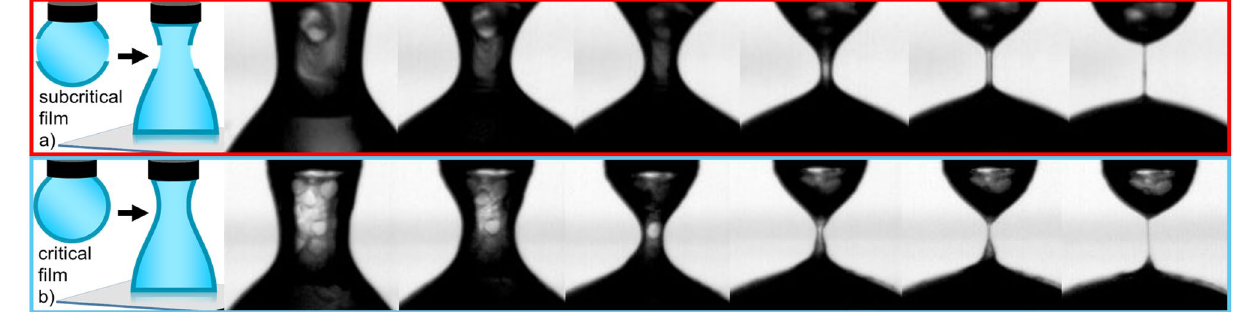
Figure 4. DoS images and schematic of proposed film formation for 3 mg/mL PEO/chloroform (no chamber). ( a ) Trial 1 exhibits subcritical film formation, where a connected film fails to span the entire bridge surface. ( b ) In trial 2, a critical film spans the entire surface, lengthening t b and (cid:31) E substantially. In both trials, the film